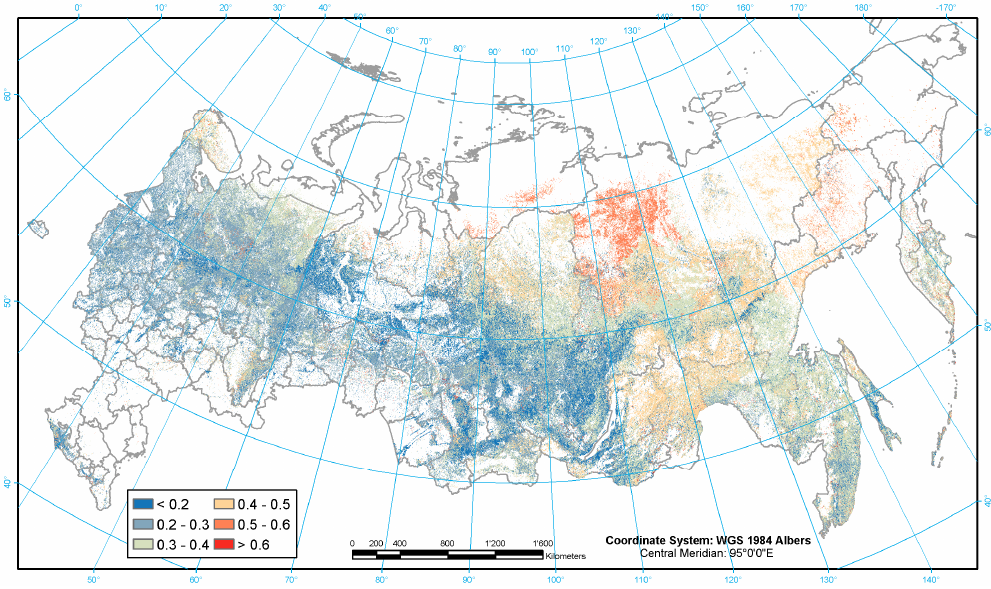
Figure 5. Geographic distribution of the root-to-shoot ratios.